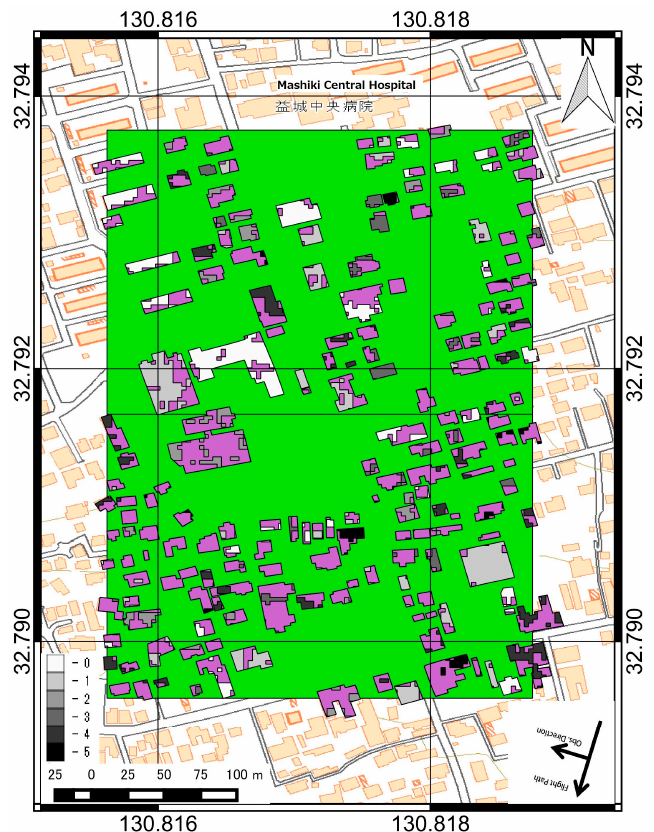
Figure 8. Damage detection results for a coherence threshold of 0.3 in the sampled region of Mashikimachi town. Overlapped on Figure 3. Purple colored regions represent the pixels for which the CD values are larger than 0.3. Table 4. Overall accuracy and Cohen’s Kappa coefficient for coherence analysis with buildings over 200 m 2 and with DL 5 or greater. Bold numbers with gray background represent the cells which accuracy and K-coefficient are over 0.7 and 0.4 respectively.